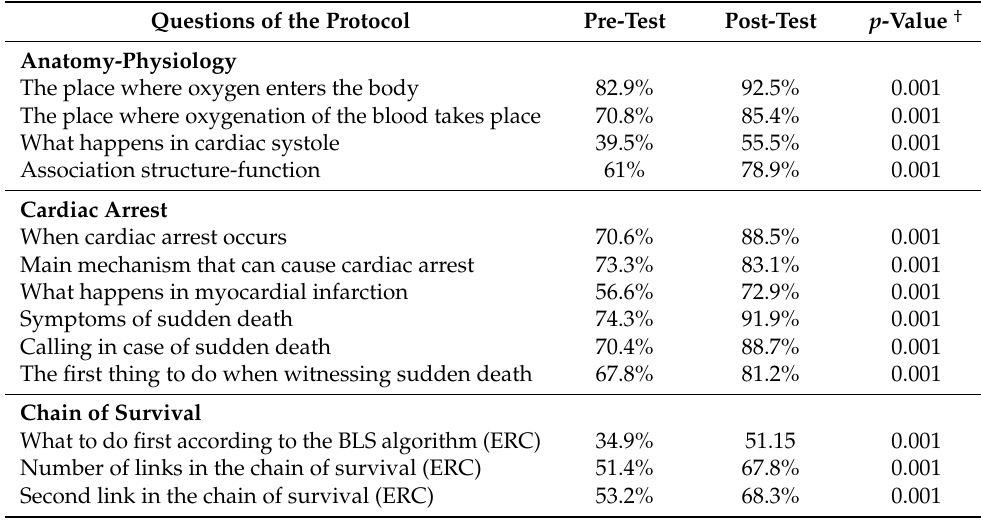
Table 3. Percentages of correctly answered questions in the pre-test and post-test theoretical assess- ments in the BLS clinical simulation